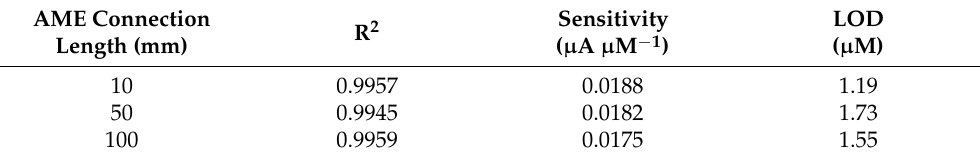
Table 3. A table comparing electroanalytical response of AMEs with different connection lengths